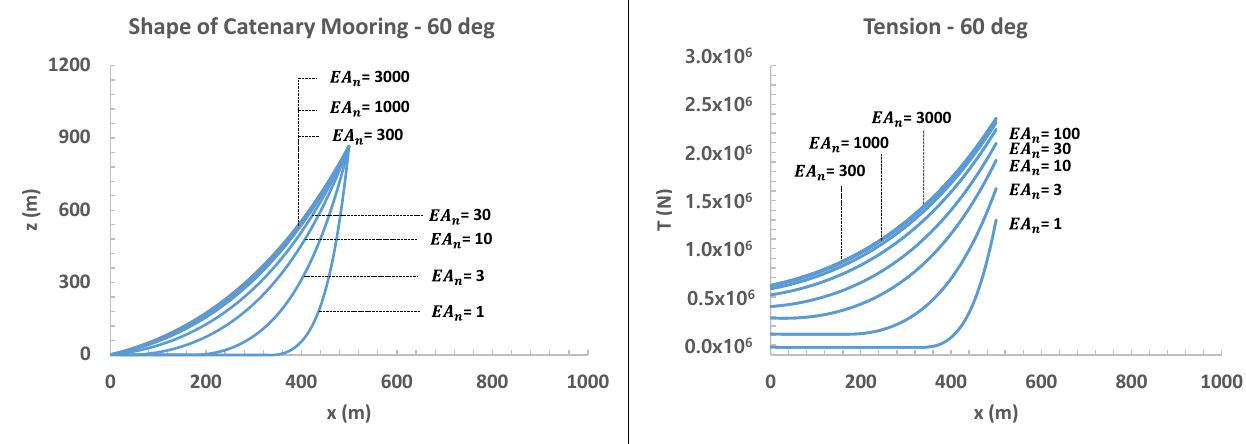
Figure 11. Results for static analysis of mooring line considering seabed condition when q is 60°.